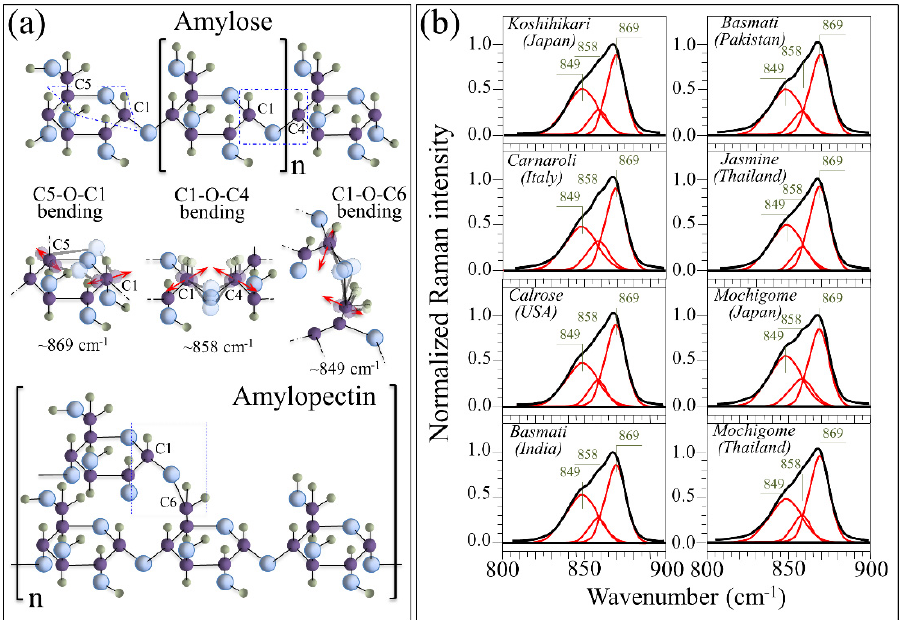
Figure 3. ( a ) Structures and the C–O–C bending modes of amylose and amylopectin; C–O–C bending modes include intra-ring C5–O–C1, inter-ring C1–O–C4 and C1–O–C6 bending vibrations found at ~869, ~858, and 849 cm − 1 , respectively. In ( b ), high-resolution Raman spectra in the 800–900 cm − 1 C–O–C bending region as collected on eight different rice cultivars from Japan and other countries (cf. labels in inset); deconvolutions into three sub-bands centered at 869, 858, and 849 cm − 1 fit the experimental signals with a confidence >95%.